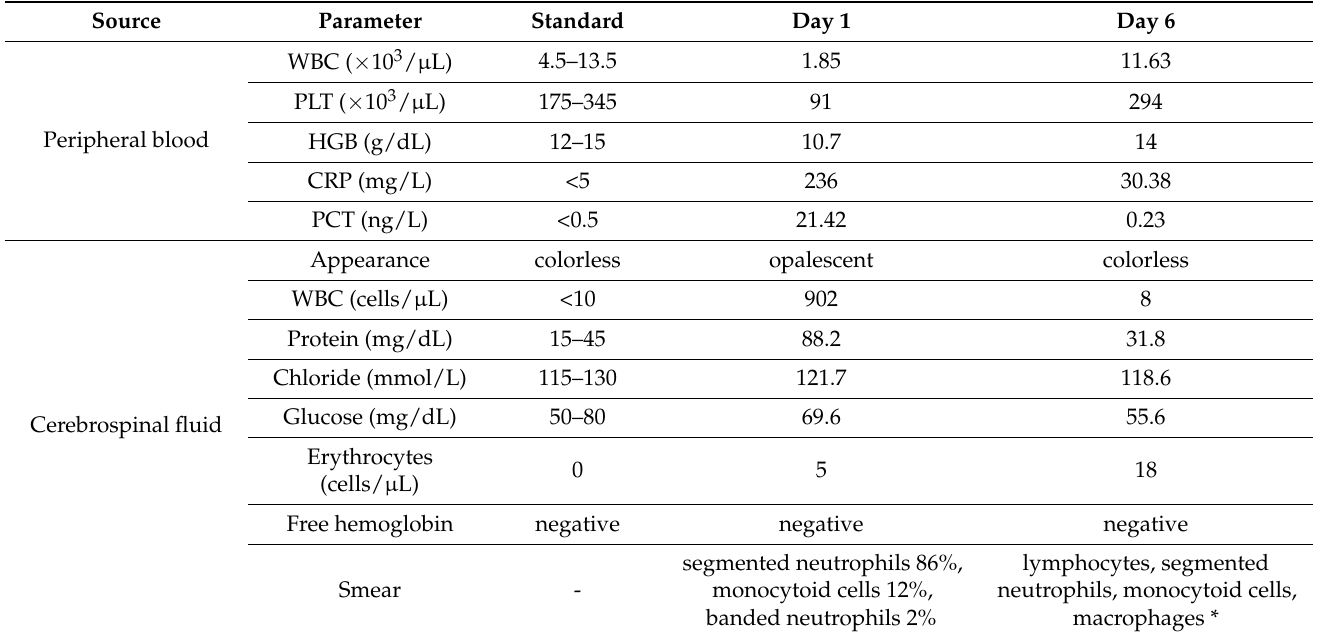
Table 1. Results of laboratory tests on the day of admission to the hospital and at day